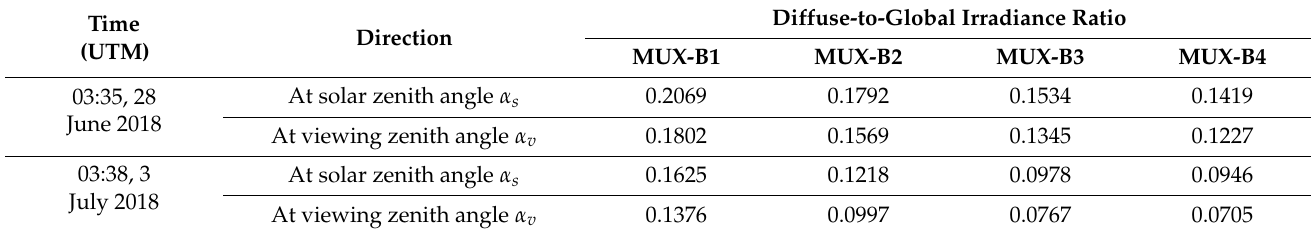
Table 4. The diffuse-to-global irradiance ratio of each MUX band.